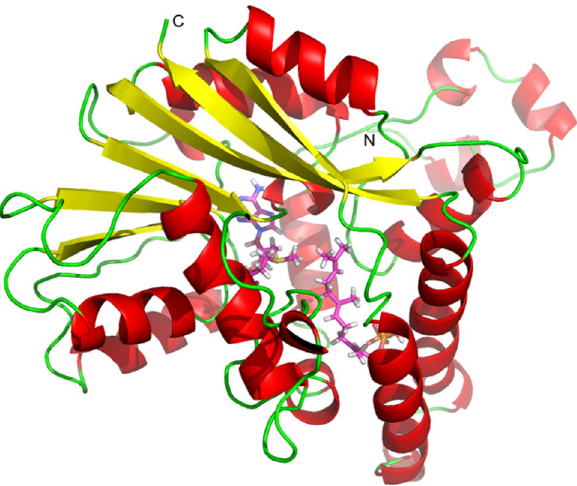
Figure 3. Tertiary structure model of the Serratia plymuthica FPP C -methyltransferase. SAM and FPP are docked into the center of the model (magenta carbon atoms).